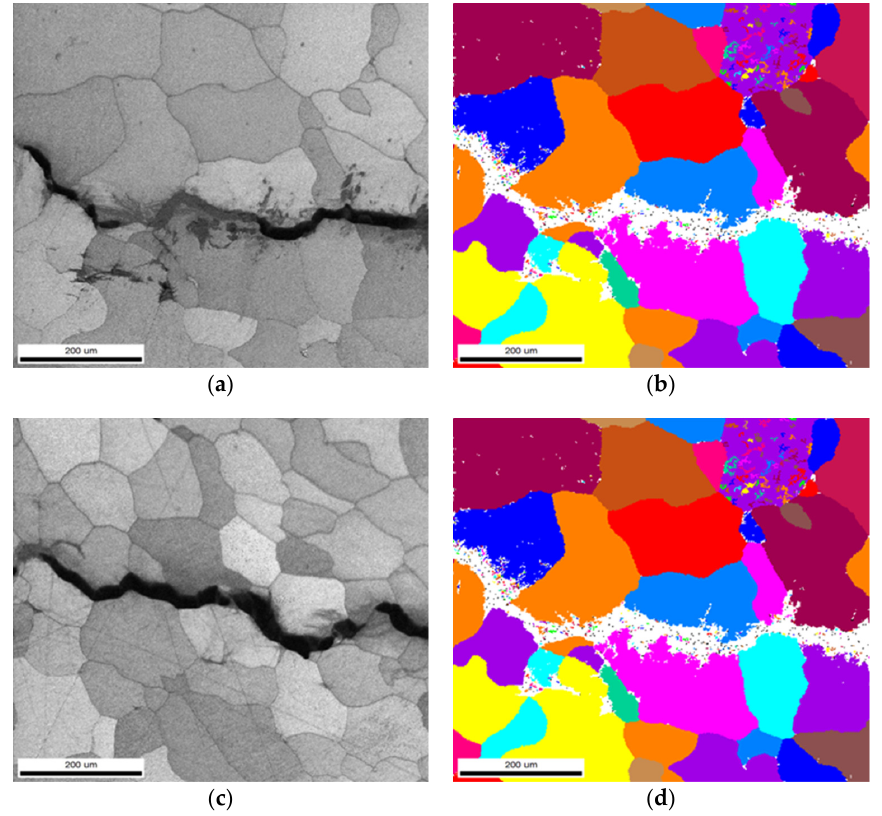
Figure 8. EBSD analysis for 7050 ingot fracture surface at crack tip: ( a , b ) ingot with Al ‐ 3Ti ‐ 0.15C grain refiner, ( c , d ) ingot with Al ‐ 5Ti ‐ 0.2B grain refiner.